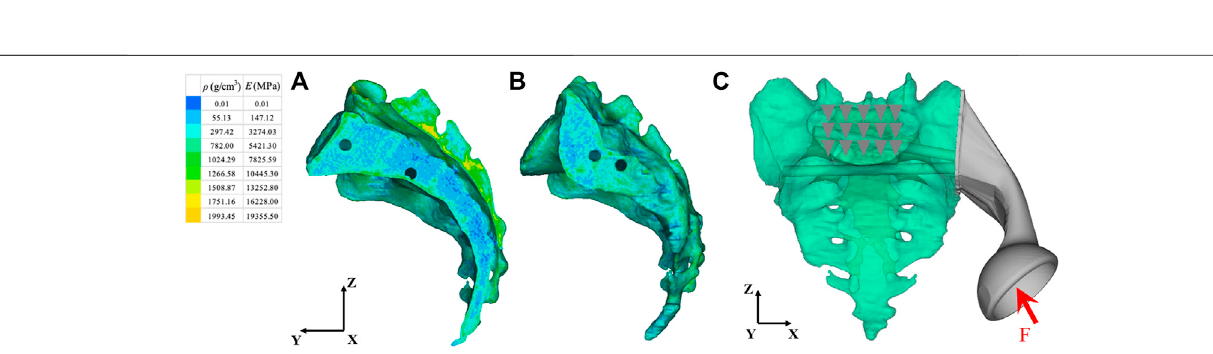
FIGURE 2 | The S1 and S2 screws are tightly connected to the hemipelvic prosthesis with acetabulum through a connecting plate. The screw is replaced by a cylinder. (A) Bone mineral density screw. (B) Long screw, and (C) short screw.